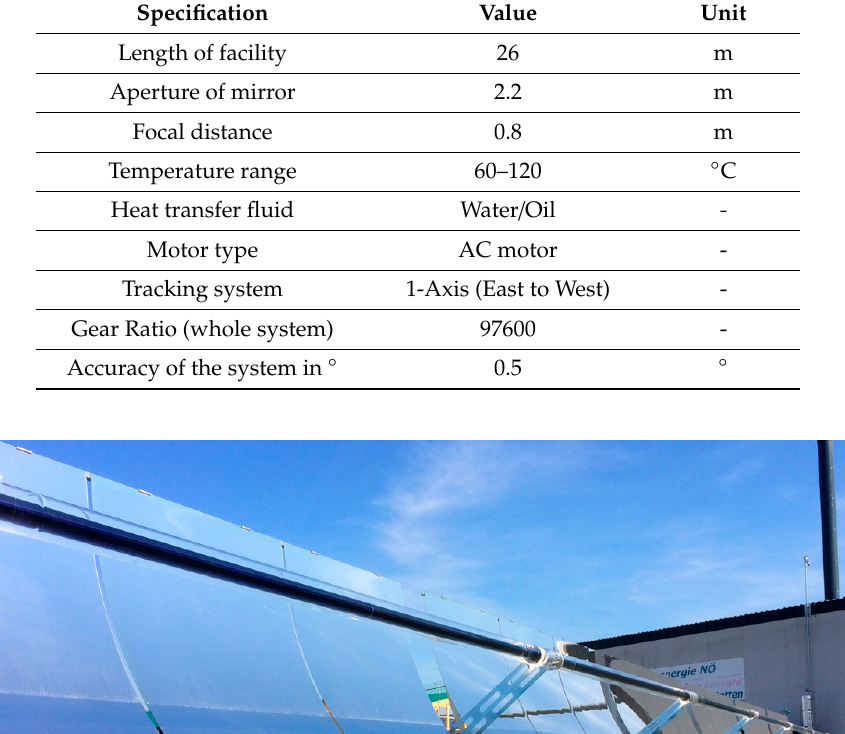
Table 2. Specifications of the SMT-8 Parabolic trough collector by IMK Solarmirrotec.